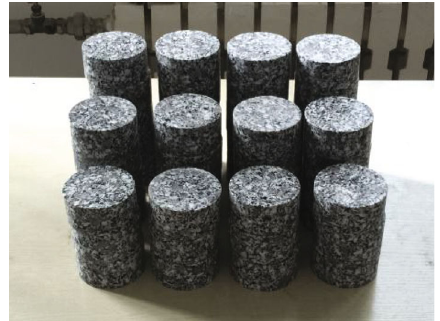
Figure 1: Part of rock specimens prepared.